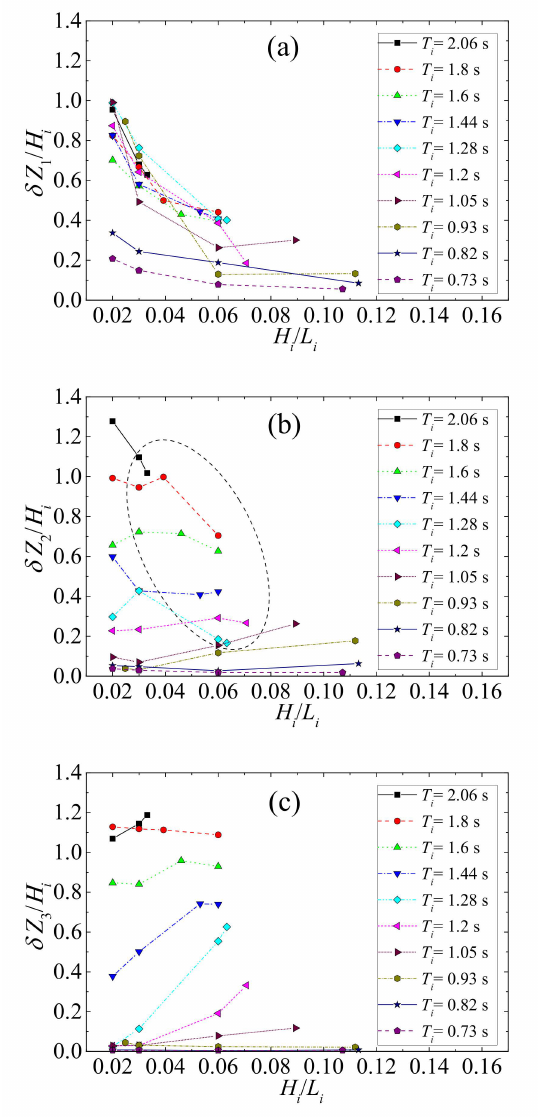
Figure 12. Nondimensional response amplitudes of the floaters: ( a ) FP1; ( b ) FP2; ( c )